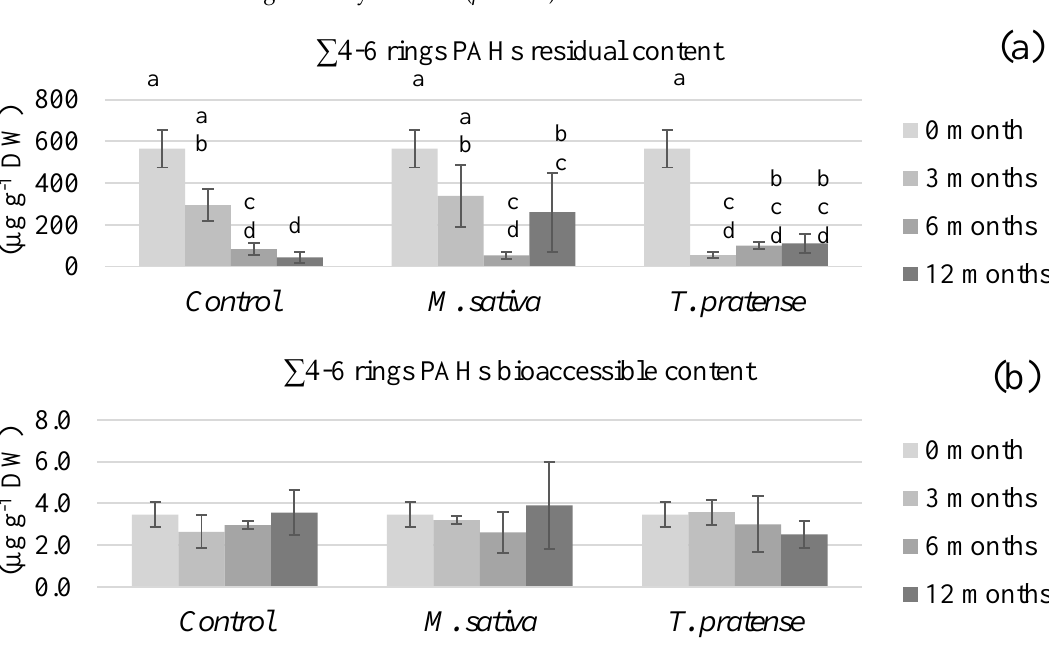
Figure 6. The total PAHs’ (∑all) ( a ) residual and ( b ) bioaccessible contents of soils planted with M. sativa L. or T. pratense L. compared to unplanted control samples after different time periods. The